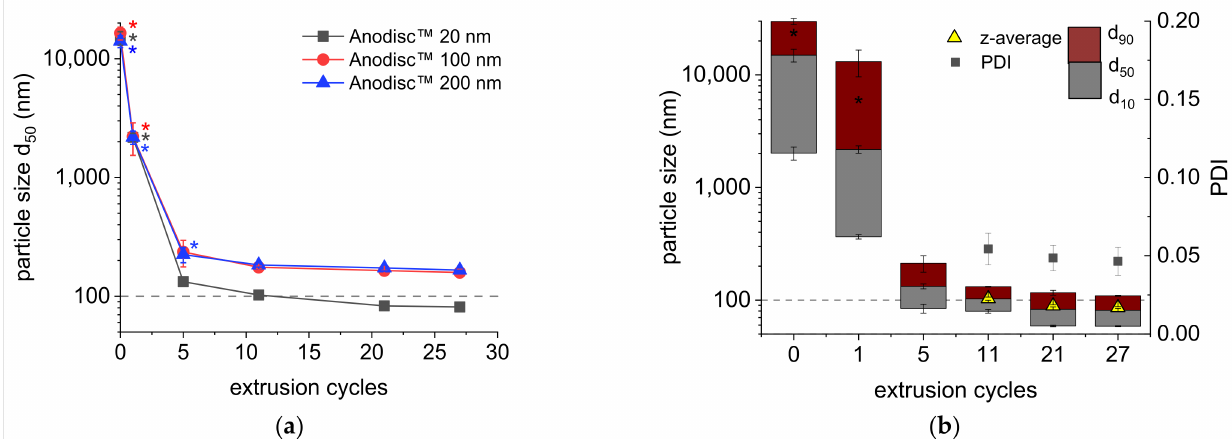
Figure 1. ( a ) Median particle sizes (d 50 ) of MCT (10%) nanoemulsions with 10% SL obtained by PME through Anodisc ™ membranes with 20 nm, 100 nm and 200 nm nominal pore size; ( b ) particle size distribution, z-average diameter and PDI of MCT (10%) nanoemulsions with 10% SL obtained by PME through a 20 nm Anodisc ™ membrane, dependent on extrusion cycle numbers (flow rate 0.2 mL/s). Mean of 3 independent experiments ( n = 3) ± standard deviation; asterisks label bimodal particle size